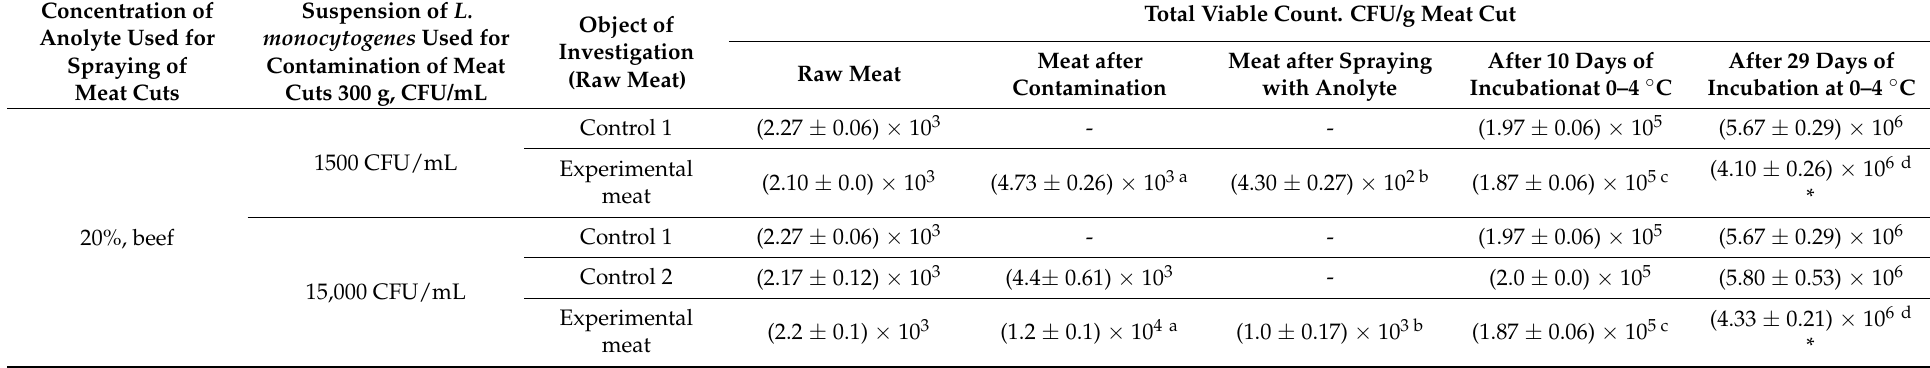
Table 2. The effect of anolyte’s concentration on the L. monocytogenes count of meat cuts contaminated with L. monocytogenes . Concentration of Anolyte Used for Spraying